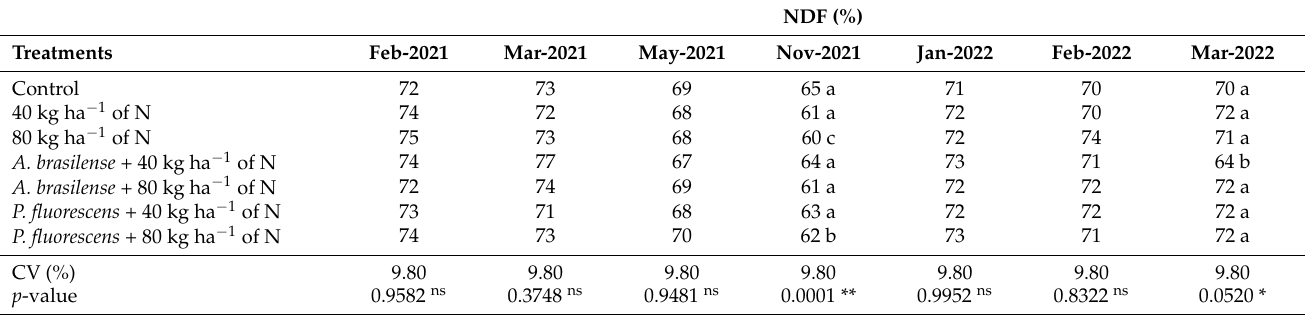
Table 7. Mean neutral detergent insoluble fiber (NDF, %) and acid detergent insoluble fiber content in (ADF, %) of the shoot of the grass Megathyrsus maximus cv. BRS Zuri inoculated with PGPB. NDF